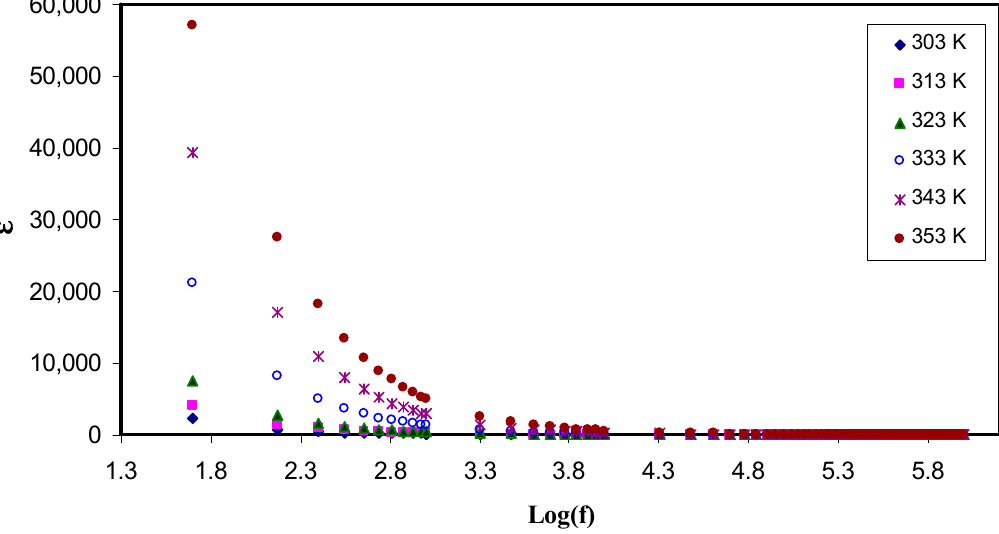
Figure 7. Dielectric loss ( ε ’ ′ ) as a function of the logarithm of frequency ( f ) at different temperatures. The dispersion in dielectric loss spectra rises with rising temperature.